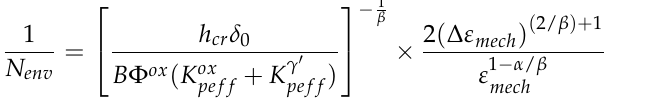
Table 1. Before the sensitization temperature range, a γ (cid:48) depleted layer lacking chromium is present between the material and Cr 23 C 6 due to the effect of Cr 23 C 6 existing on the surface of austenitic stainless steel [1,42]. In addition, in the sensitization